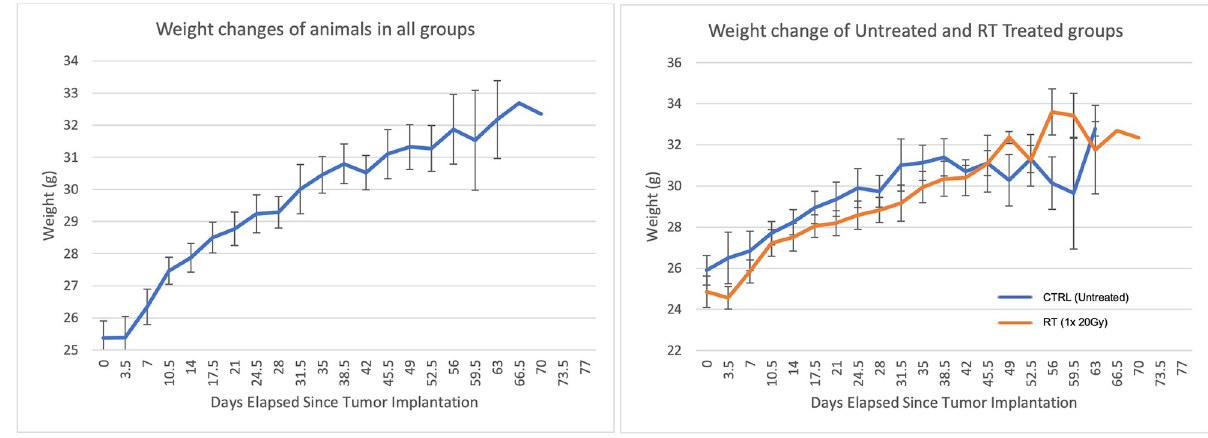
Fig 7. Average animal weights across all groups post-surgery (left), n = 27, and animal weights as divided by treatment group (right) showing CTRL group animals (blue), n = 14, and RT animals given one dose of 20 Gy (orange), n = 13. Both left and right lung implanted animals responded similarly and were grouped together for analysis. Days elapsed refers to the number of days since initial tumor cell implantation.